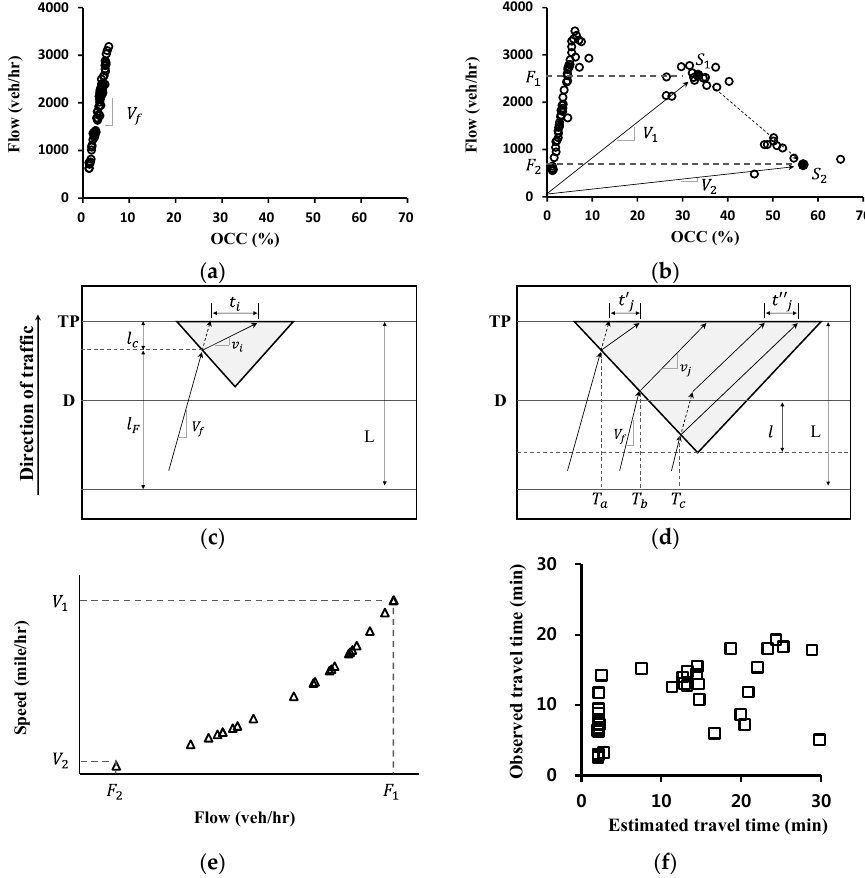
Figure 2. ( a ) Fundamental diagram remained within the free flow state. ( b ) Fundamental diagram entering the unstable flow state, monitoring the tail of the queue and determining affected links. ( c ) Hypothetical situation in which the queue started from the toll plaza but not reaching D .